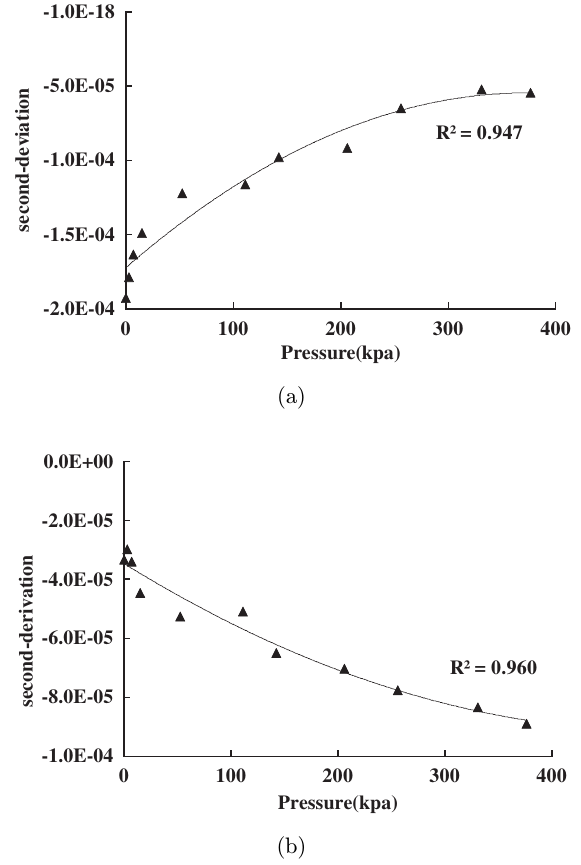
Fig. 6. Variations of (a) bulk and (b) bound water with probe